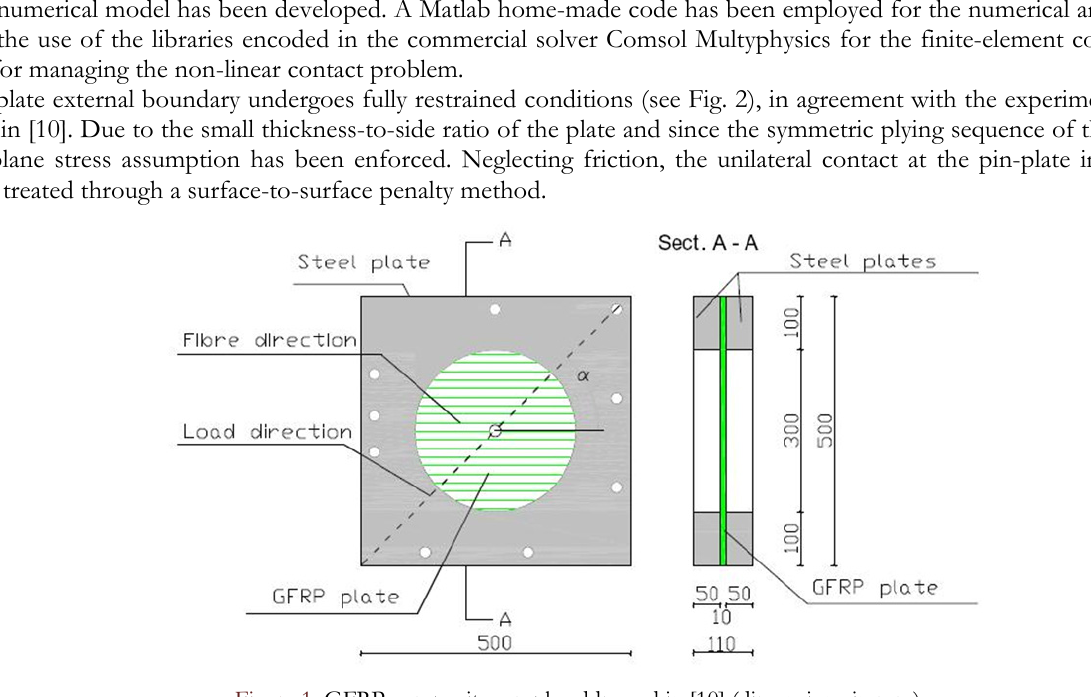
Figure 1: GFRP composite sample addressed in [10] (dimensions in mm).